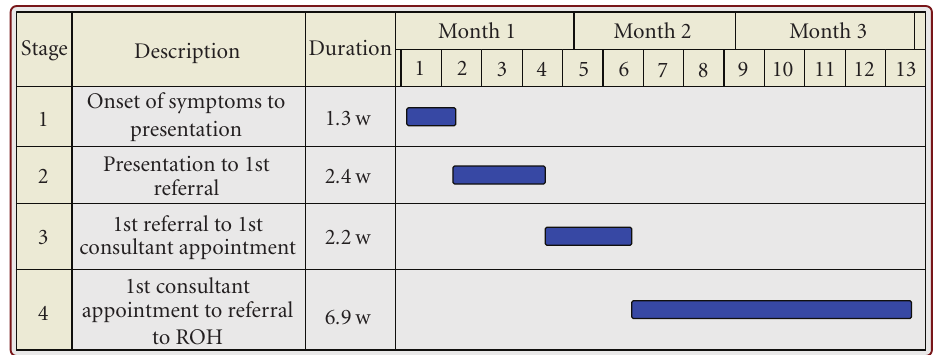
Figure 2: The median patient.